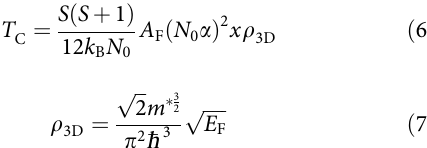
) are likely related to the Fe-related IBs. The bias voltages 2 ½ 110 (cid:4) where the fourfold term ( C 4 ½ 100 (cid:4) ) and the twofold terms ( C 2 ½ 010 (cid:4) and C ) appear in the diffusion region are very close, as shown 2 ½ 110 (cid:4) in Fig. 4c, indicating the overlap of these Fe-related IBs with the CB bottom and/or the VB top of (In,Fe)As. This result is